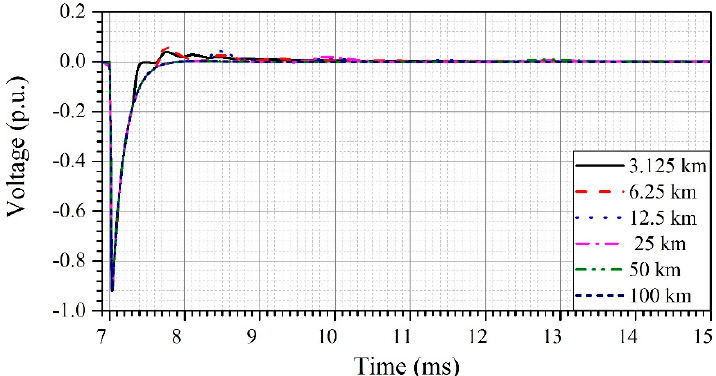
Figure 16. Sheath-ground overvoltage at the sending end terminal of the cables considering different cable lengths.